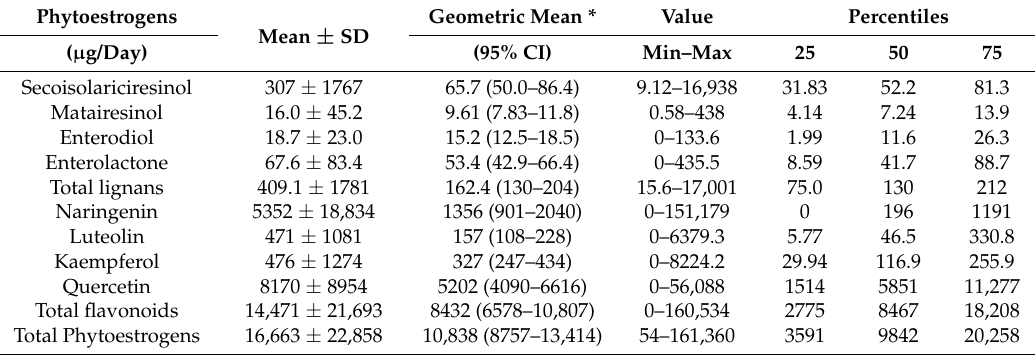
Table 4. Lignan, flavonoid, and total phytoestrogen intakes estimated by the 24 h recall in Mexican women ( n = 100).